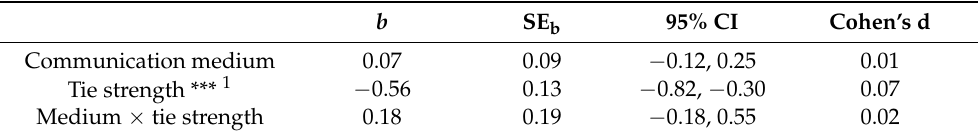
Table 3. Parameter estimates and effect sizes of all fixed effects for the analysis of the effect of communication medium and tie strength on interaction intimacy. b SE b 95% CI Cohen’s d Communication medium 0.07 0.09 − 0.12, 0.25 0.01 Tie strength *** 1 − 0.56 0.13 − 0.82, − 0.30 0.07 Medium × tie strength 0.18